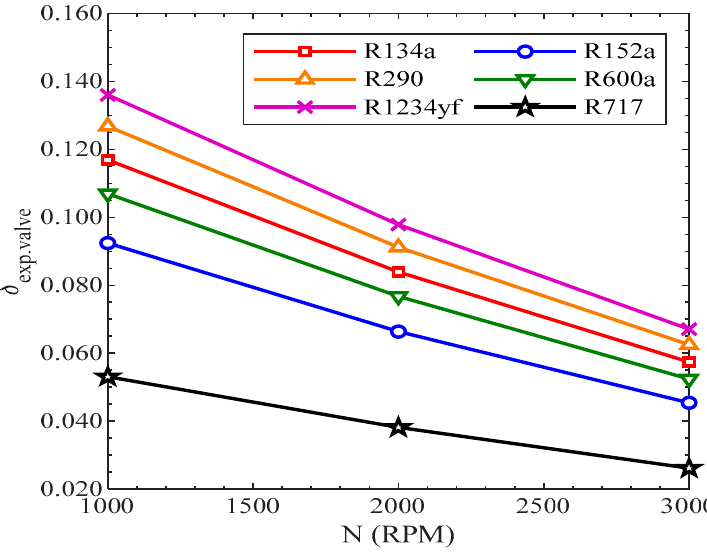
Figure 20 . Efficiency defect of expansion valve .